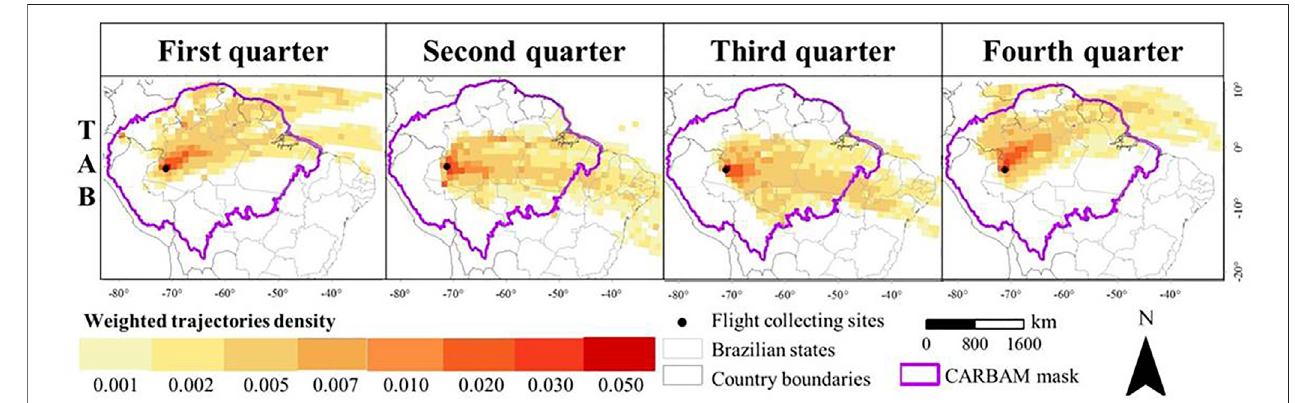
FIGURE 3 | Weighted mean quarterly regions of in fl uence for 2010 through 2018 for the TAB site (5.9 ° S, 70.0 ° W). Adapted from Cassol et al. (2020) and Basso et al. (2021), where methods are